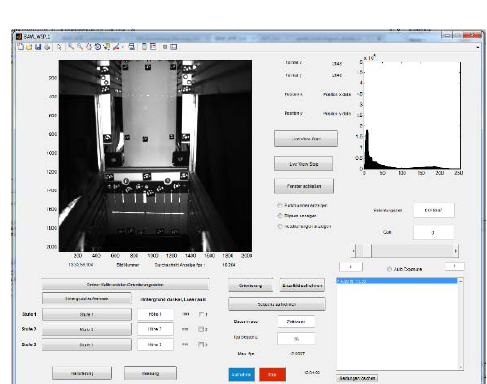
Figure 18: Left: Actual system with slit plate as front projection plane, Right: laser projection with slit plate (moving water)